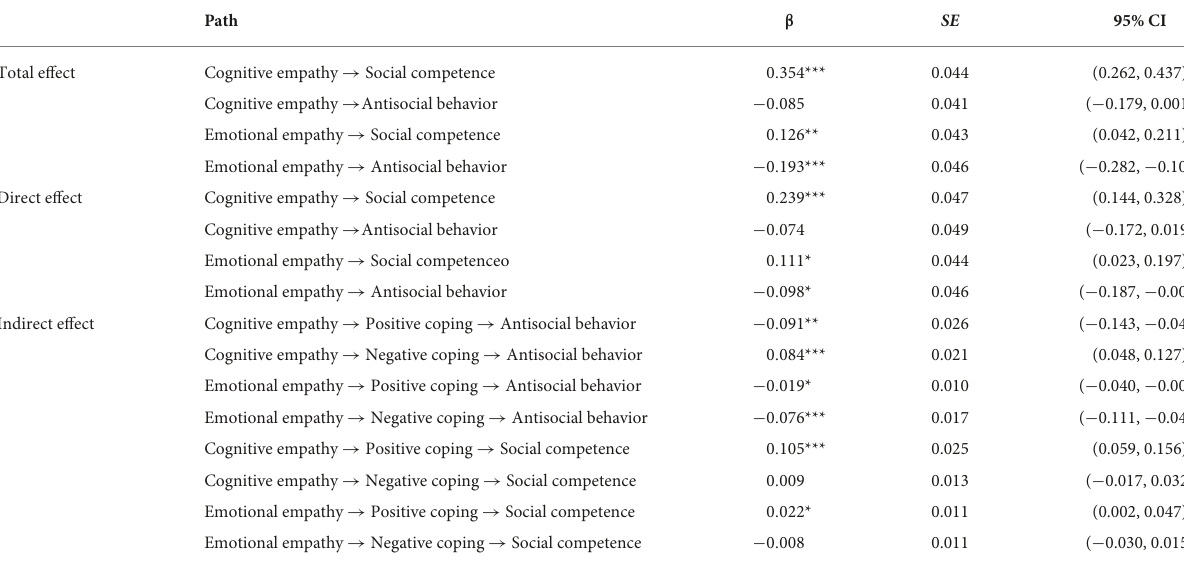
TABLE 2 Standardized indirect effects from empathy to school